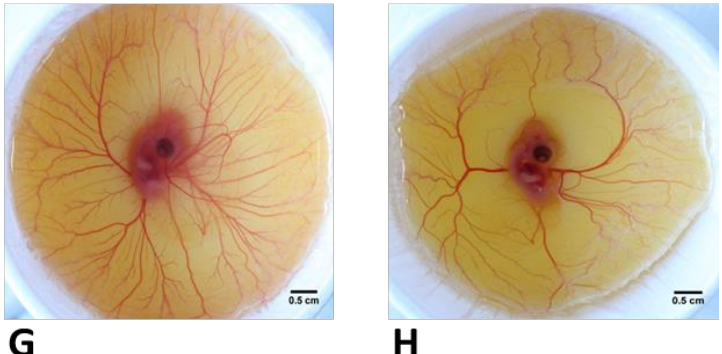
Figure 4. Development extra-embryonic vasculature of control embryo ( A , C , E , G ) and Y-27632 (500 µ M)-treated embryo ( B , D , F , H ) at 60 h (( A , B )–prior to treatment), 60 + 24 h ( C , D ), 60 + 48 h ( E , F ), and 60 h + 4 d ( G , H ). Following administration of agents, embryos in the experimental group revealed strikingly impaired neovascularization with reduced formation of blood vessels and reduced circulation of the yolk sac when compared with controls at 24 h ( C , D ), 48 h ( E , F ), and 4 d ( G , H ) post-treatment. Scale bars 0.5 cm.